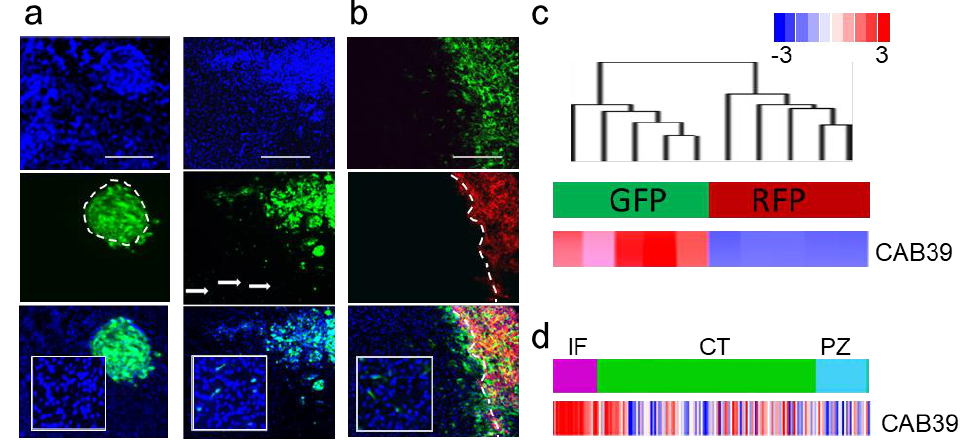
Figure 2. Characterization of primary GSC phenotype. ( a ) Representative images of intracranial xenografts (nodular GBM9—left, invasive GBM12—right, cells are GFP-labeled, blue—DAPI staining). ( b ) Invasive (GBM12 GFP-labeled) and nodular (GBM9 RFP-labeled) GSCs retain their phenotype in co-injection model in vivo (blue—DAPI staining). ( c ) Hierarchical clustering of gene expression in cells isolated from heterogeneous tumors ( n = 5 independent tumor separated for GFP and RFP cells respectively) in unsupervised analysis (top cluster) and CAB39 expression (bottom bar). ( d ) CAB39 expression was retrieved from Ivy GAP database-based expression signature in different anatomic areas of GBM (IT, infiltrating tumor; CT, cellular tumor; PZ, perinecrotic